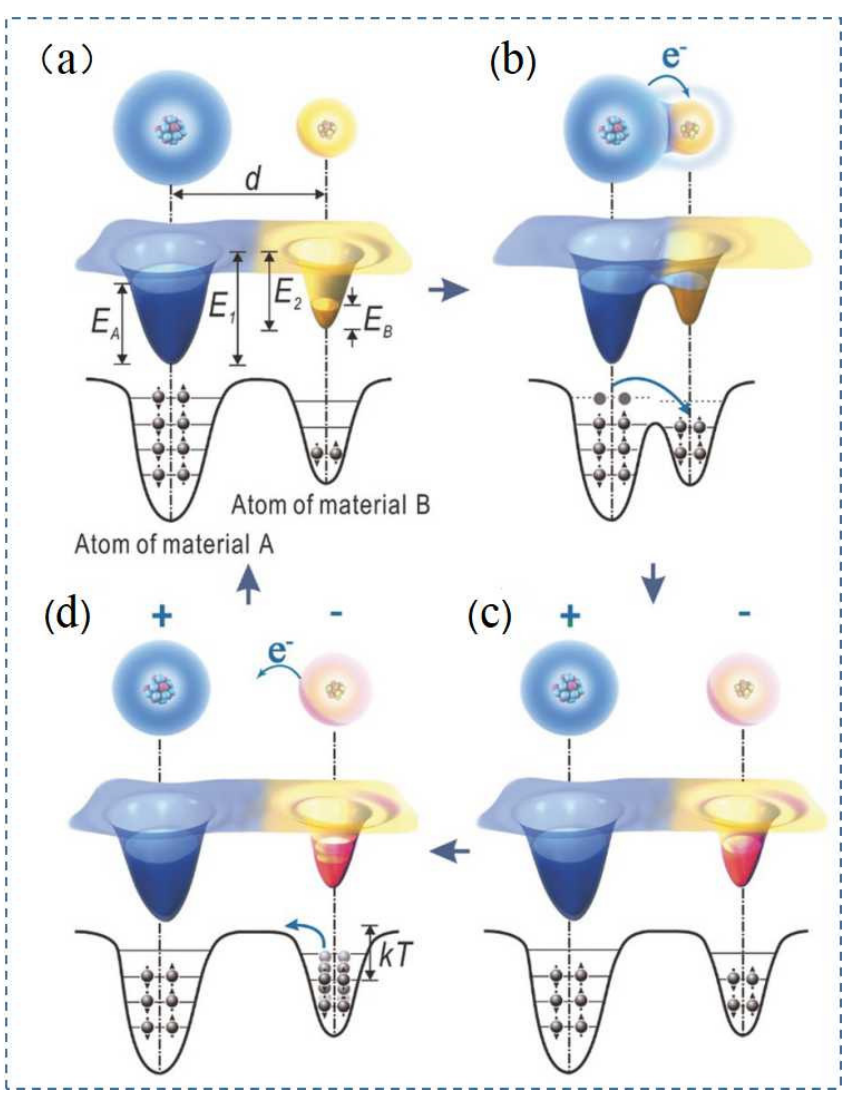
Figure 3. Electron transfer model of TENG. Reprinted with permission from ref. [56]. Copyright 2018 Advanced Materials. ( a ) Material A and material B before contact; ( b ) the two materials in contact; ( c ) the two materials separated; and ( d ) with increasing temperature, electric charges were released by the atoms.